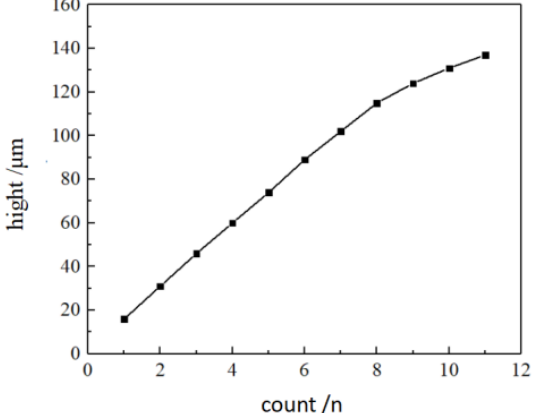
Figure 15. Relationship between the number of ablations and the height of the ortho-hexagonal boss.